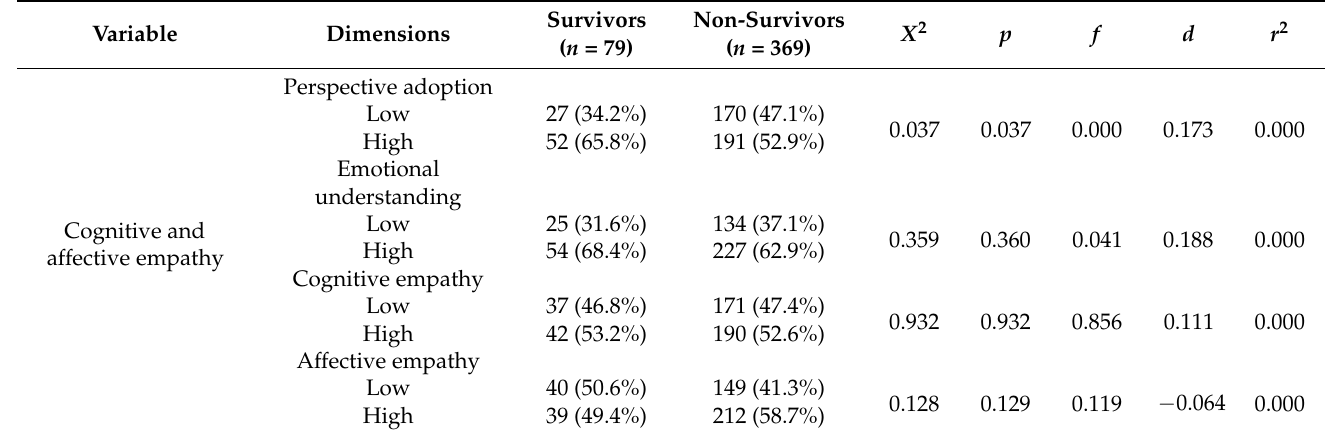
Table 3. Cognitive and affective empathy as a function of survivor